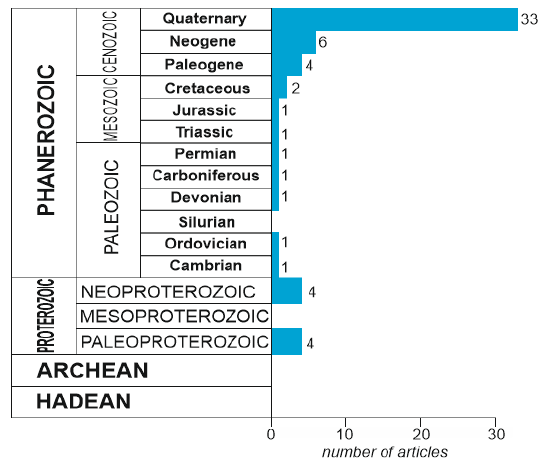
Figure 3. Geological age of megaclasts studied during 2000–2017; the geological time scale after Ogg et al. [80] (created by authors).